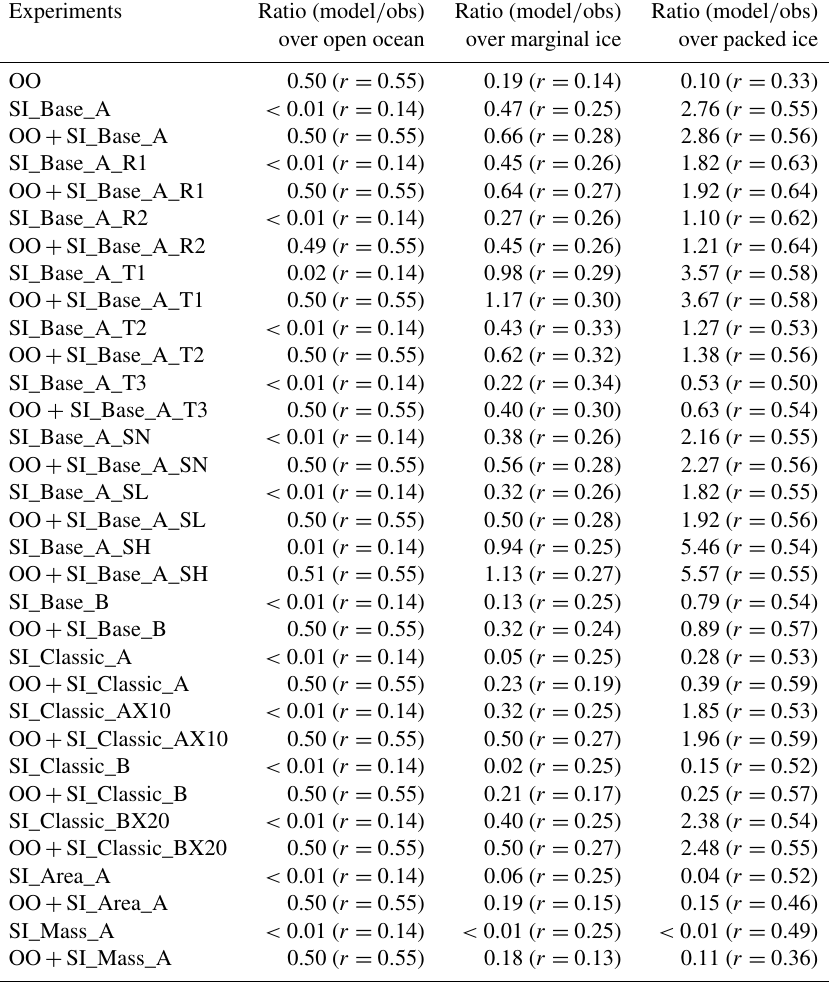
Table 2. Ratios of aerosol number density between model runs and the observations (for overlapping size range of 0.4–12µm) along the cruise track over the surface types open ocean (column 2), marginal sea ice (column 3) and packed sea ice (column 4). The values in brackets are the correlation coefficient between time series of model output and the observation at each surface